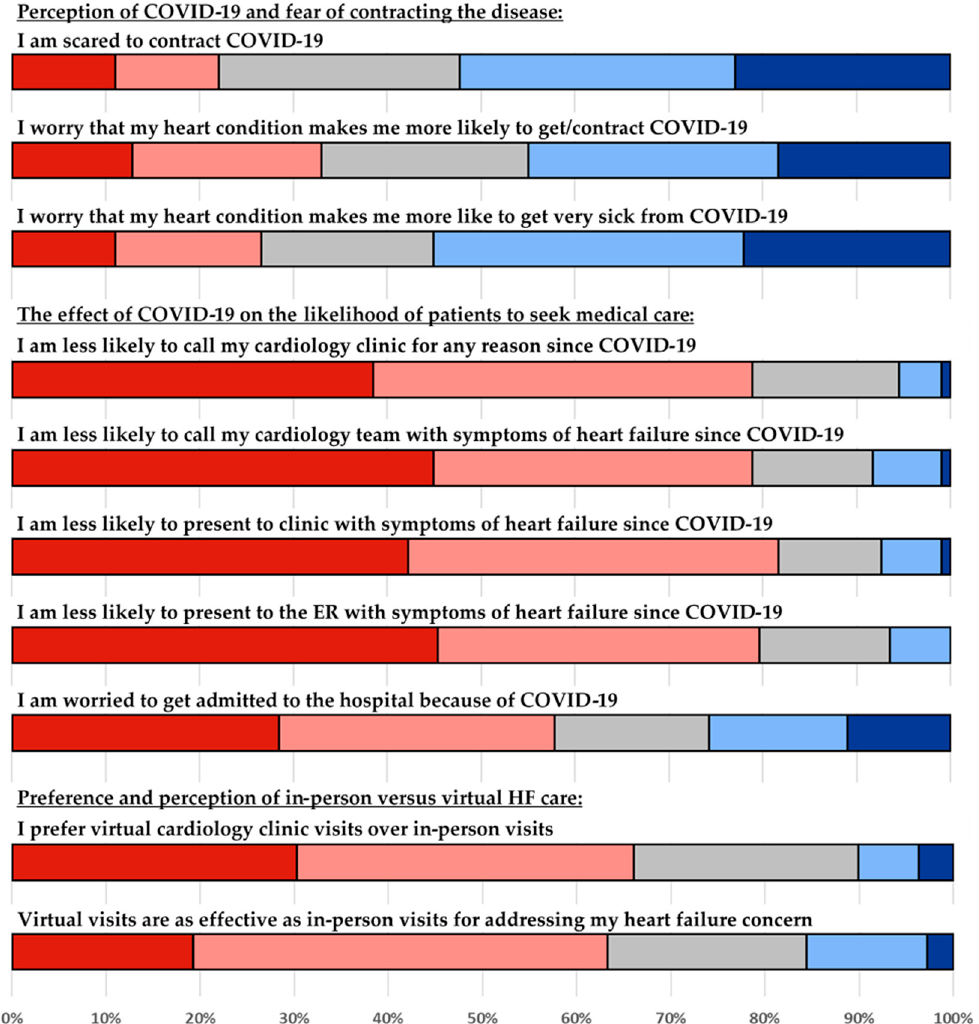
Figure 1. Survey questions and responses shown on a Likert scale with a range of − 2 to 2. Strongly disagree ( − 2, red), Disagree ( − 1, pink), Neither agree nor disagree (0, grey), Agree (1, light blue), Strongly agree (2, dark